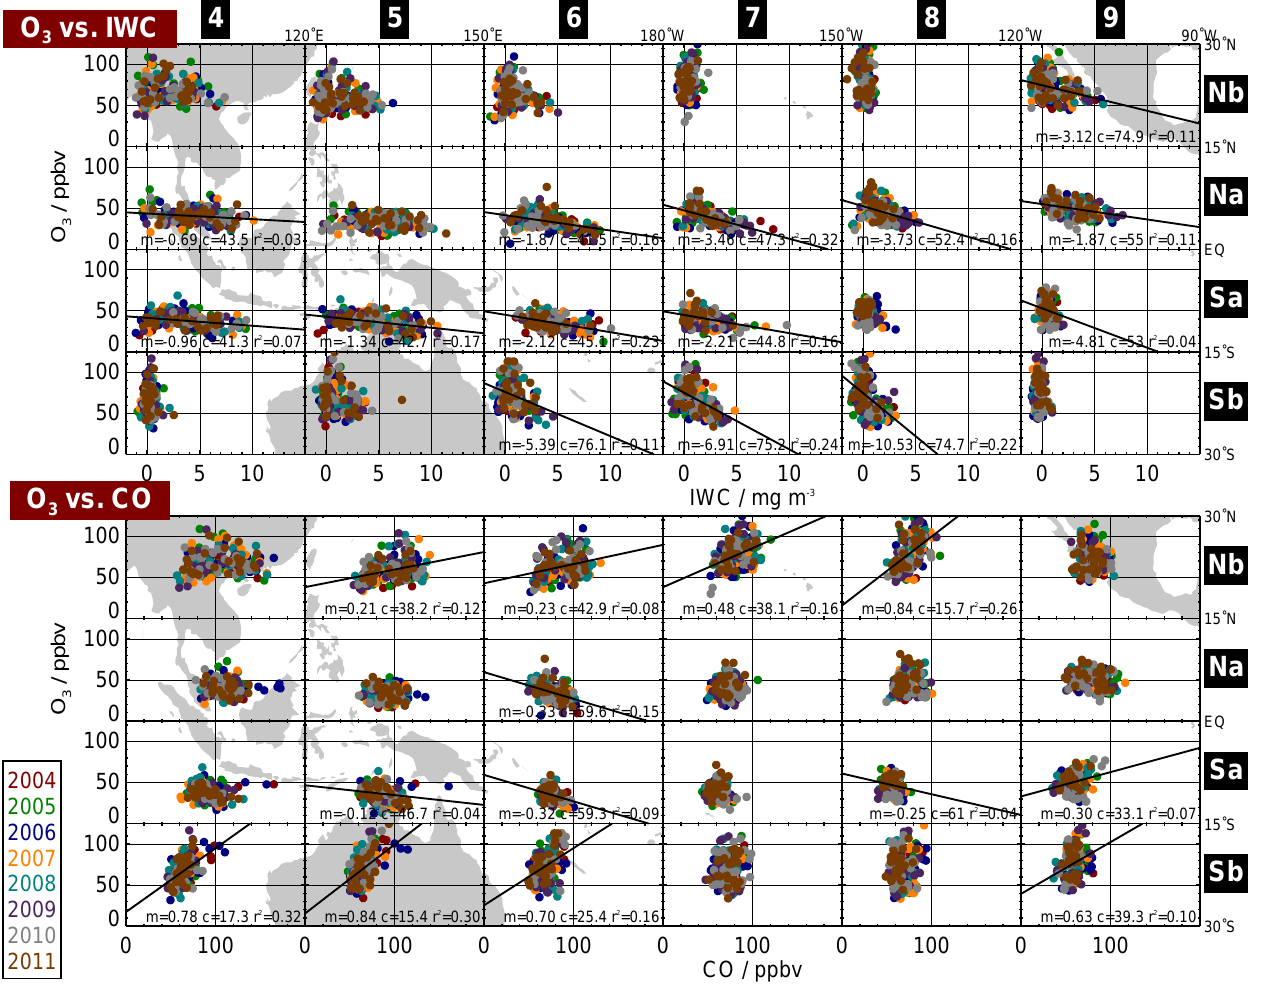
Fig. 7. As for Fig. 6 but for 90 ◦ E to 90 ◦